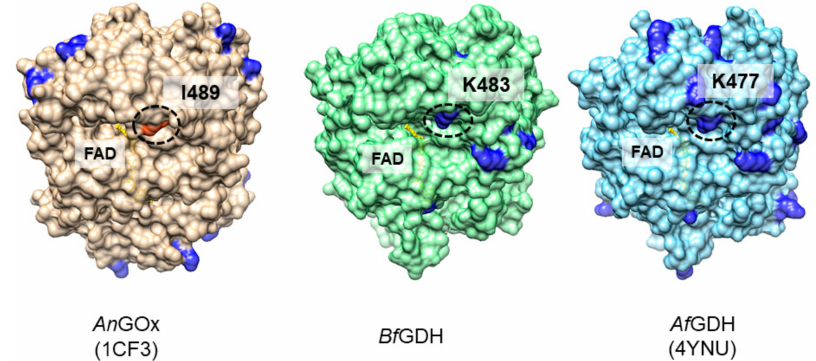
Figure 1. Comparison of the positions of lysine residues in Aspergillus niger derived glucose oxidase ( An GOx) (PDB ID: 1CF3), Botryotinia fuckeliana derived glucose dehydrogenase ( Bf GDH) (model), and A.flavus derived GDH ( Af GDH) (PDB ID: 4YNU). Lysine residues are shown in dark blue. In Bf